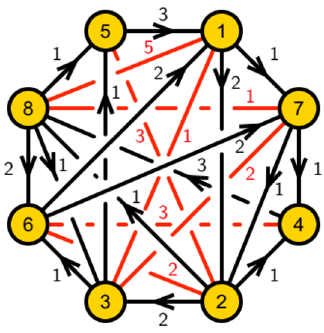
Figure 22 . Quiver for Model